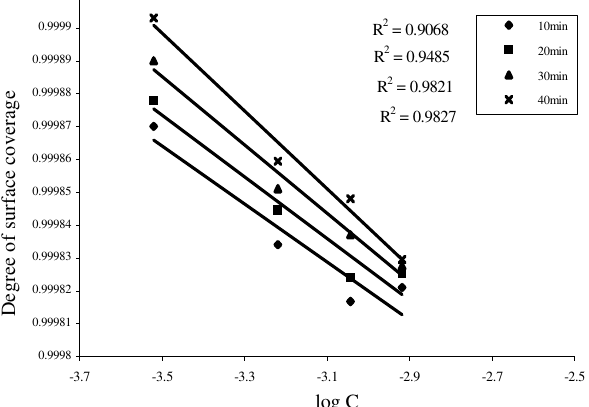
Figure 6 . Curve fitting for adsorption of Pb ion on oyster shell according to Temkin isotherm. Table 3. Values of Temkin parameters for adsorption of Pb 2+ on oyster, snail and periwinkle shells . Interaction parameter, a K